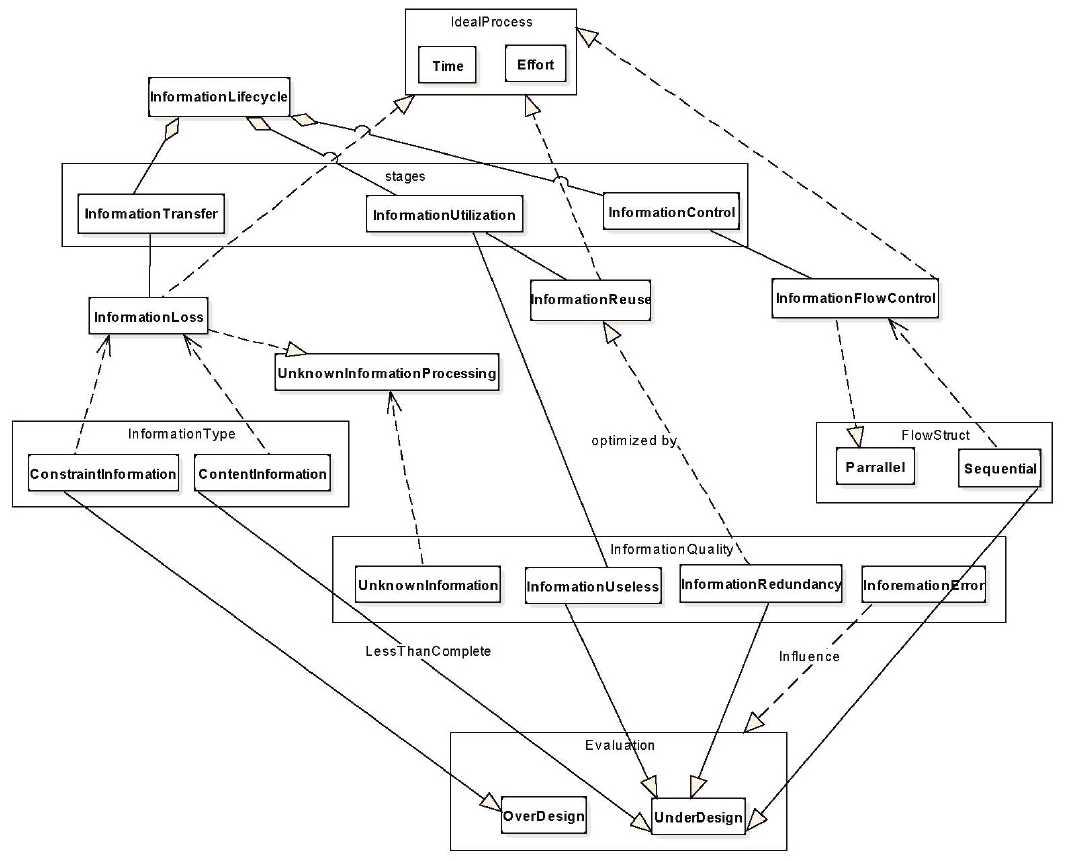
Figure 1: Revelation of the sources of UD and OD from an information life cycle